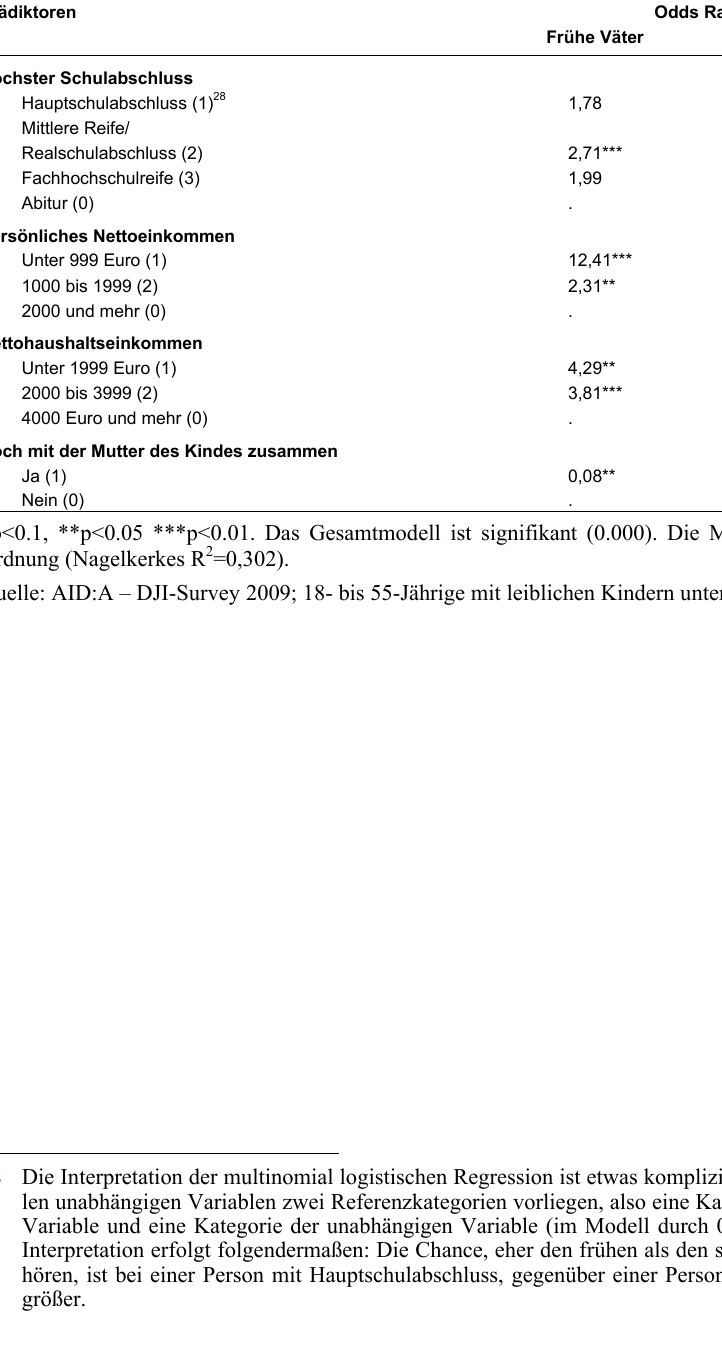
Tabelle A2 : Multinomial logistische Regression, Väter, Referenzkategorie späte Väter Prädiktoren Odds Ratios Höchster Schulabschluss Hauptschulabschluss (1) 28 Mittlere Reife/ Realschulabschluss (2) Fachhochschulreife